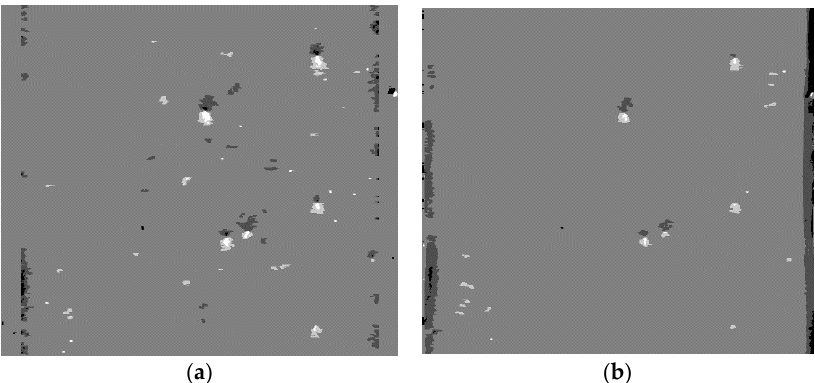
Figure 11. Results of area extraction. ( a ) Result of partition area extraction; ( b ) Result of traditional area extraction without partition processing.